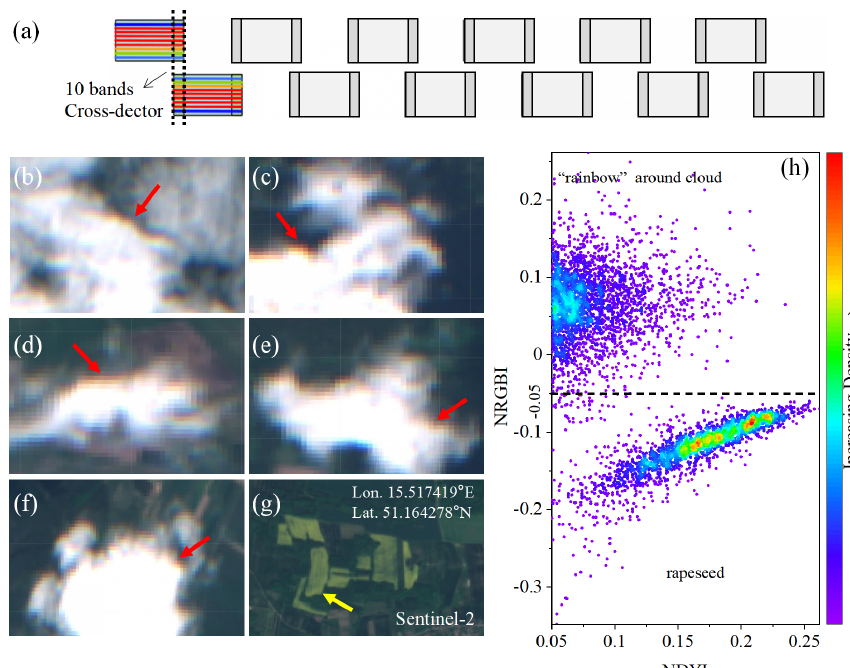
Figure 5. “Rainbow” cloud effect origins, examples, and solutions. (a) Staggered detector configuration of S2 (ESA, 2015a). (b) – (f) Exam- ples of spectral misregistration effects and the performance of cloud-masking methods. Each image was masked with the quality assurance band (QA60) for the Sentinel-2 TOA image. The red arrows indicate the “rainbow” appearing around clouds at high altitudes in the S2 image (image source: Copernicus Sentinel-2 data). (g) Sentinel-2 TOA image of rapeseed at the flowering stage. The yellow arrow indicates rapeseed fields. (h) Scatter plot of NDYI vs. NRGBI of rapeseed field samples and samples with a “rainbow” around clouds in the S2 images. Relative pixel density is indicated by the color scale on the